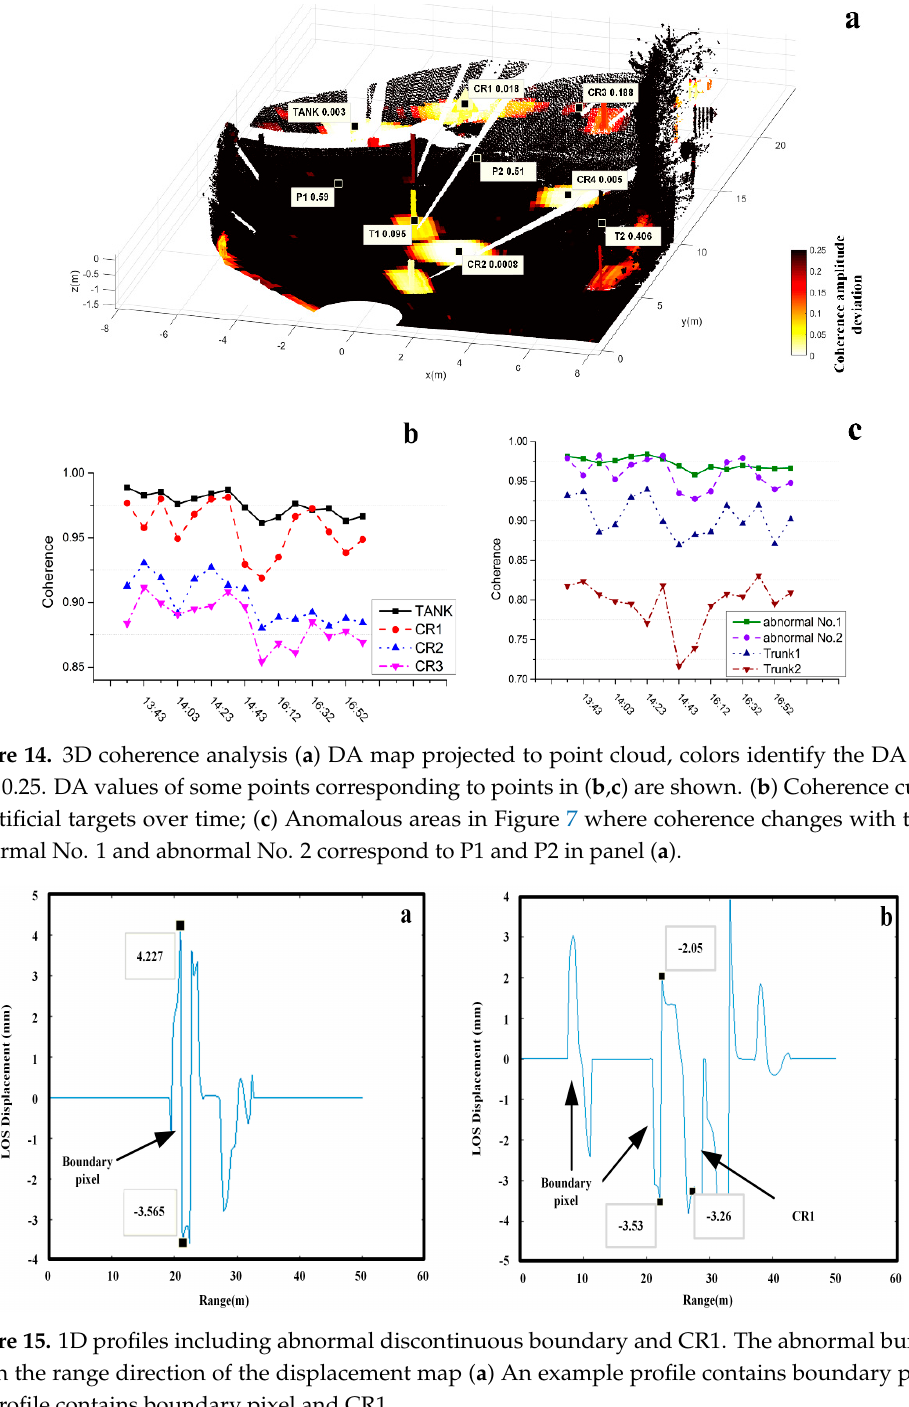
Figure 14b. Linear displacement has no corresponding peak in the opposite direction, so a linear window filtering algorithm can be used to optimize the results.